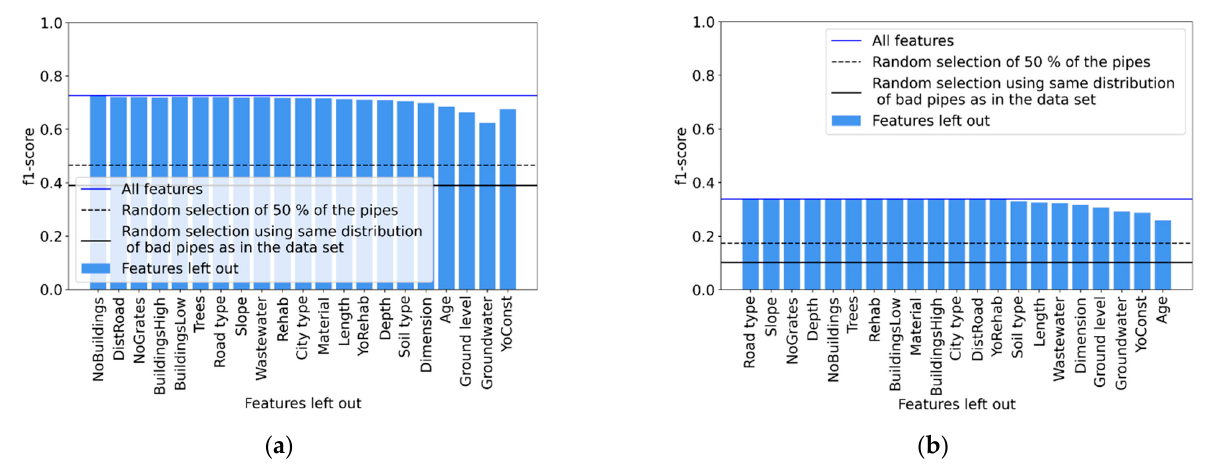
Figure 4. ( a ) Same as baseline but with the same amount of training data as available when solely considering pipes in CS 4 as being in bad condition. ( b ) Feature step analysis when solely considering pipes in CS 4 as bad.